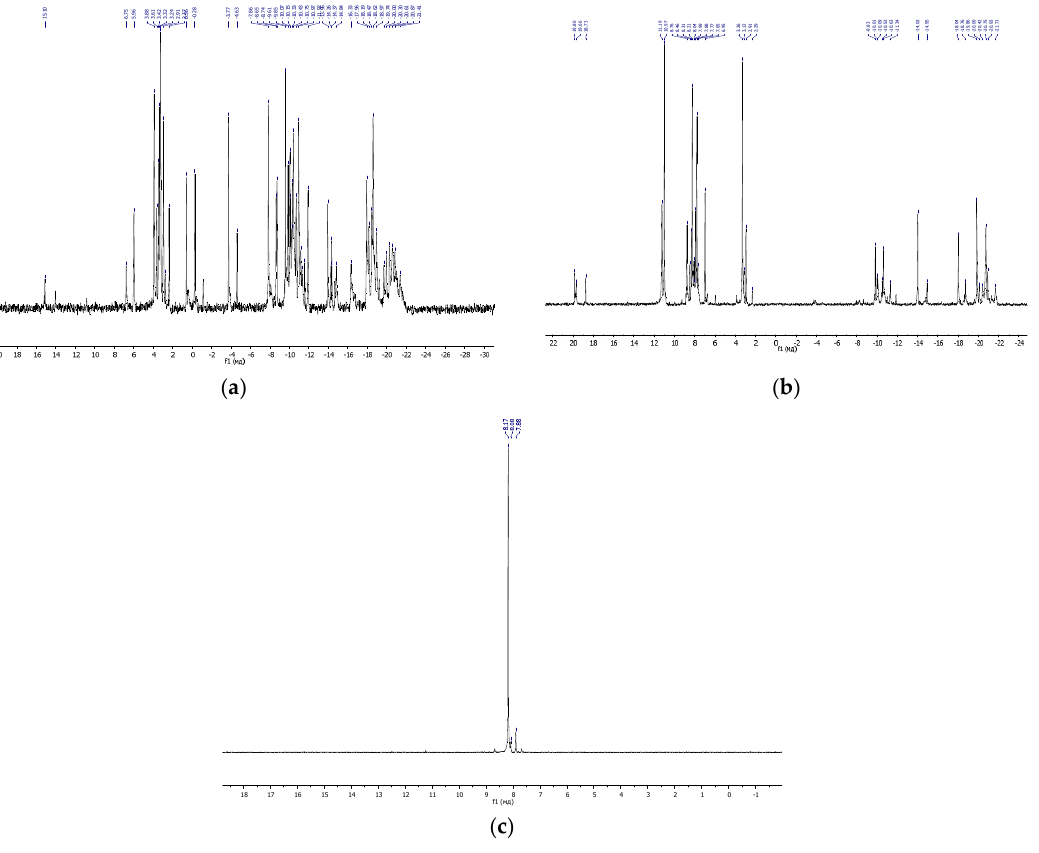
Figure 4. 29 Si NMR spectra of chloride IL 7 ( a ), IL 9 ( b ), and IL 8 ( c ).